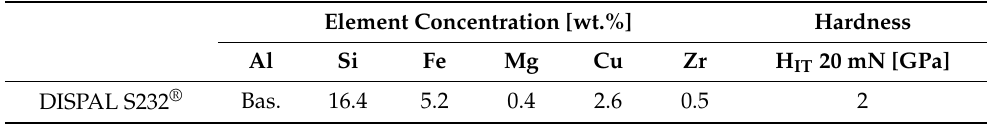
Table 1. Chemical composition and hardness (F state) of the base material. Element Concentration